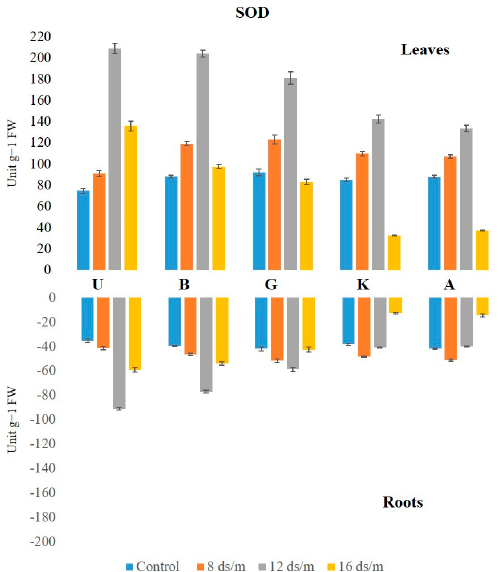
Figure 2. Effect of NaCl-mediated stress at 100 days of treatment on SOD activity in leaves and roots of pistachio.